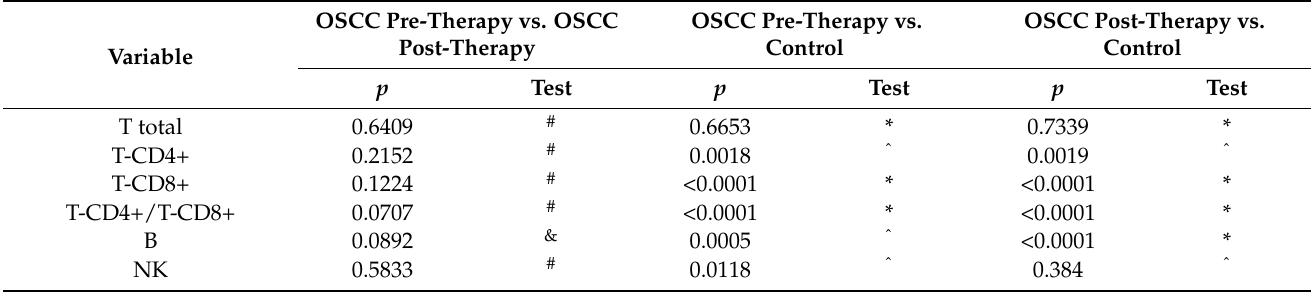
Table 4. Comparative evaluation between